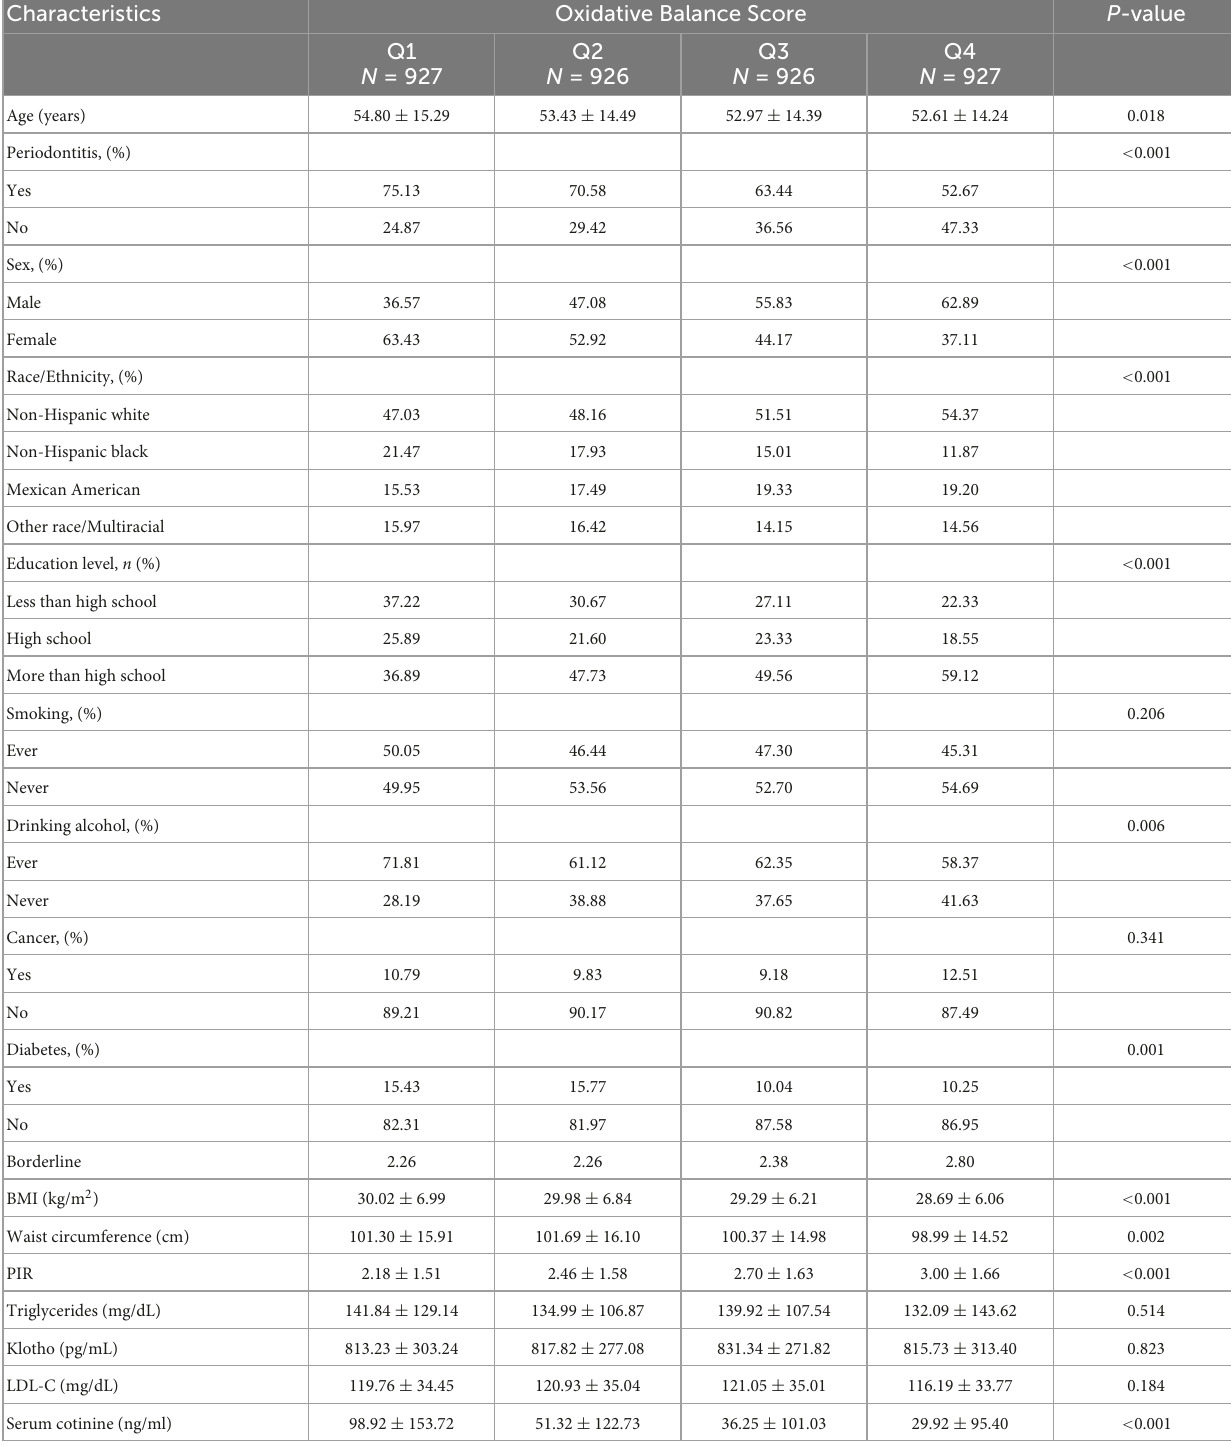
TABLE 2 Basic characteristics of participants by Oxidative Balance Score quartile.